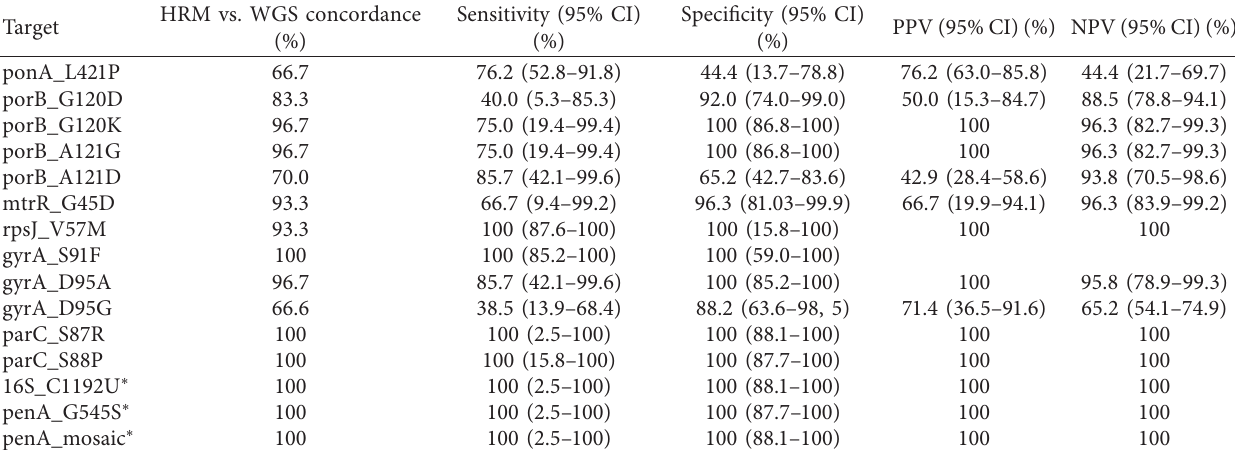
Table 2: Comparison of high-resolution melt assay and whole-genome sequencing (gold standard) for the detection of antimicrobial resistance determinants in Neisseria gonorrhoeae clinical isolates and control strains. HRM vs. WGS Target